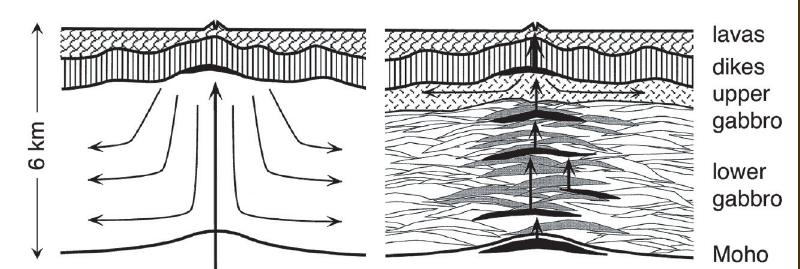
Figure 3. The lower oceanic crust forms from subsurface crystallization of igneous rock beneath spreading centers, forming gabbros. The site of crystallization is poorly known. Does all of the crystallization occur in a “shallow melt lens” near the surface, where heat can be extracted efficiently, after which gabbros undergo ductile flow downward and outward (left), or do gabbros crystallize in many stacked melt lenses throughout the crust (right)? Studies of chemical variation and crystal orientation in the lower crust of the Oman ophiolite can resolve this question. Modified from Kelemen et al. (1997).